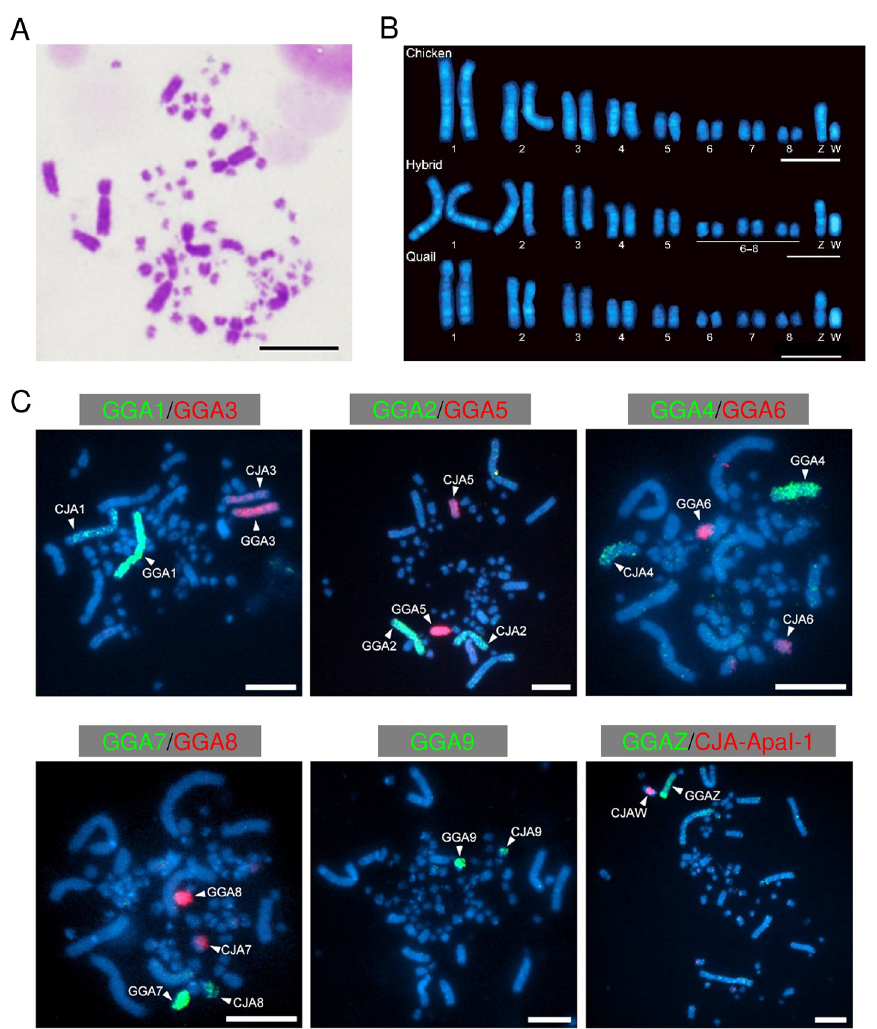
Fig 1. Chromosome analysis of chicken–quail F 1 hybrids. A. Giemsa-stained metaphase spread of a blastodermal cell of the chicken-quail F 1 hybrid, consisting of large-sized macrochromosomes and small-sized microchromosomes. B. Hoechst-stained chromosomes of cultured fibroblast cells from embryos of the chicken, chicken–quail hybrid, and quail, which show eight pairs of macrochromosomes and the Z and W sex chromosomes. The sizes of each pair of chromosomes differ between the chicken and quail chromosomes in the hybrid. C. Chromosome painting with macrochromosome-specific DNA probes and hybridization with the W-specific DNA repeat in fibroblast cells of the hybrids. Larger macrochromosomes with stronger hybridization signals are considered to be derived from chicken (GGA, Gallus gallus ), and the others from quail (CJA, Coturnix japonica ). Scale bars, 10 μ m.